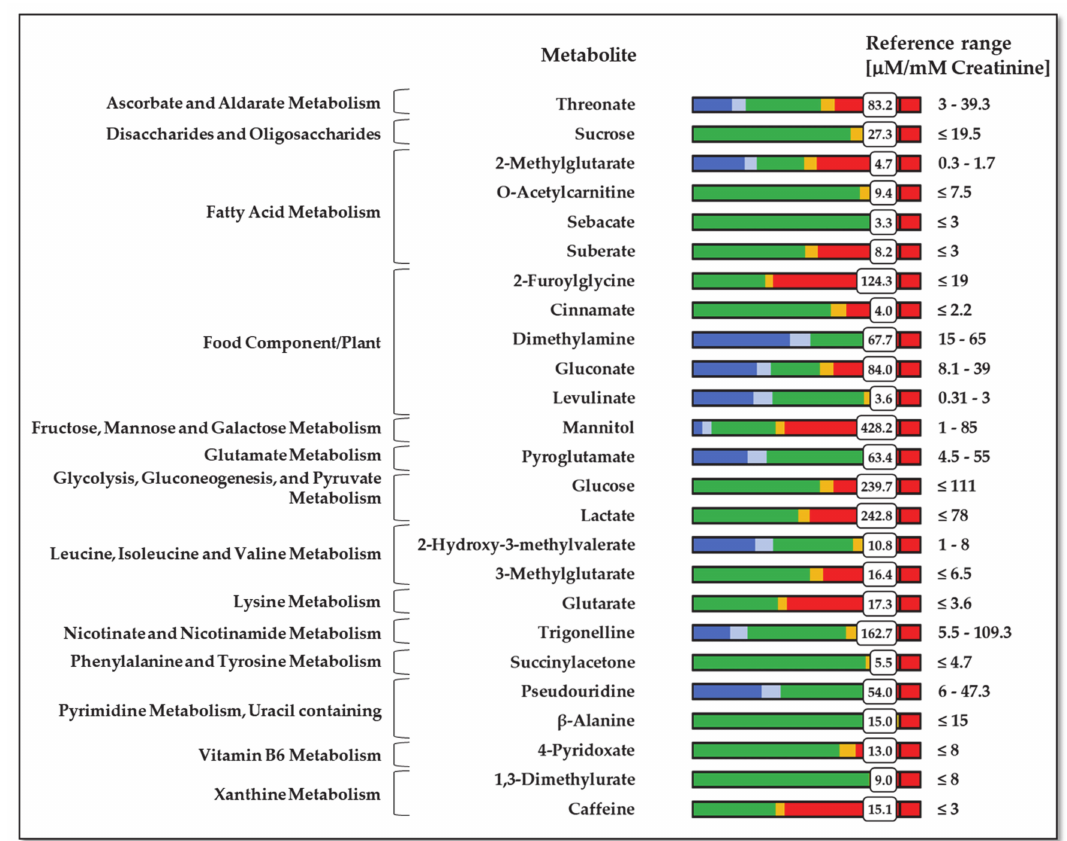
Figure 5. Urinary metabolites of a BC patient showing abnormal values according to literature ranges. Blue and red areas represent 10% lower and higher values than those reported in the literature for adults over 18 years old, respectively. All values are expressed in µ M/mM of